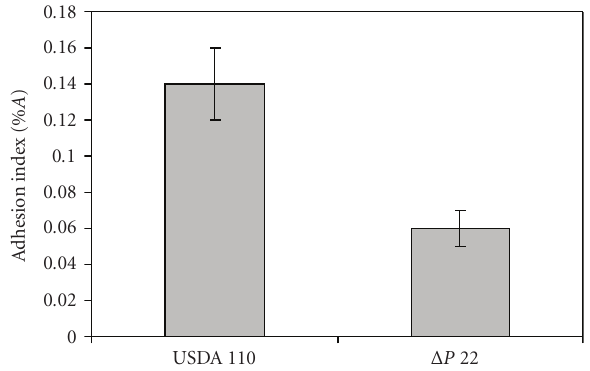
Figure 7: Adhesion of B. japonicum USDA 110 or Δ P22 to soybean roots, as quantified with the adhesion index,